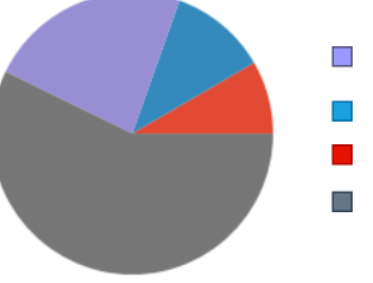
Figure 2. Distribution of the severity of bradykinesia in the